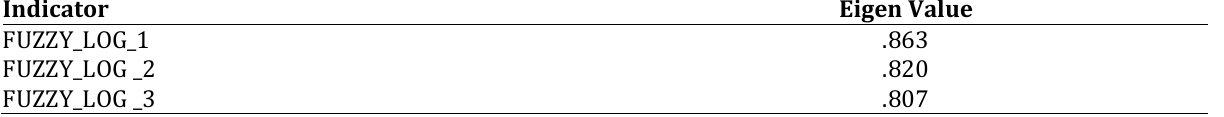
Table 14: Eigen scores of the first principal component Indicator Eigen Value